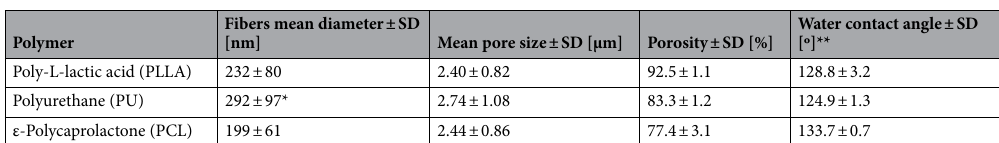
Table 1. Mean fibers diameter, nanofibrous scaffolds pore size, and porosity. *Sample differs from the rest with p < 0.001. **Water contact angle values differ from each other with p < 0.001.